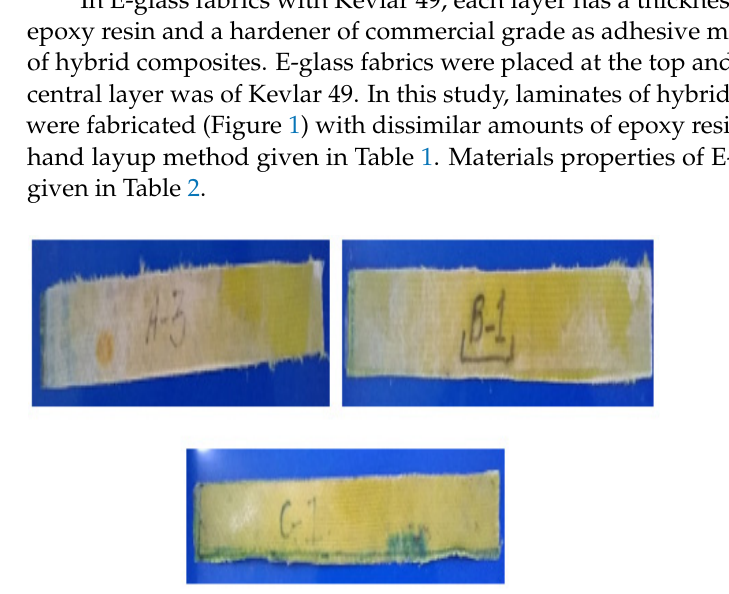
Table 1. Layup placement of glass fibers and Kevlar 49 by applying different ratios of resin and hardener .